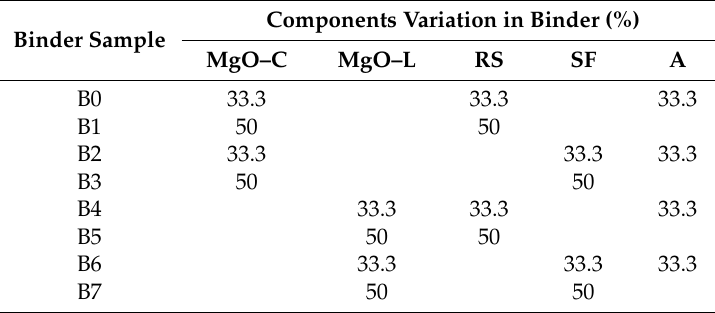
Table 2. Components variation in MgO–binder (RS—river sand; SF—silica fume; A—alkaline admixture). Components Variation in Binder (%) Binder Sample MgO–C MgO–L RS SF A B0